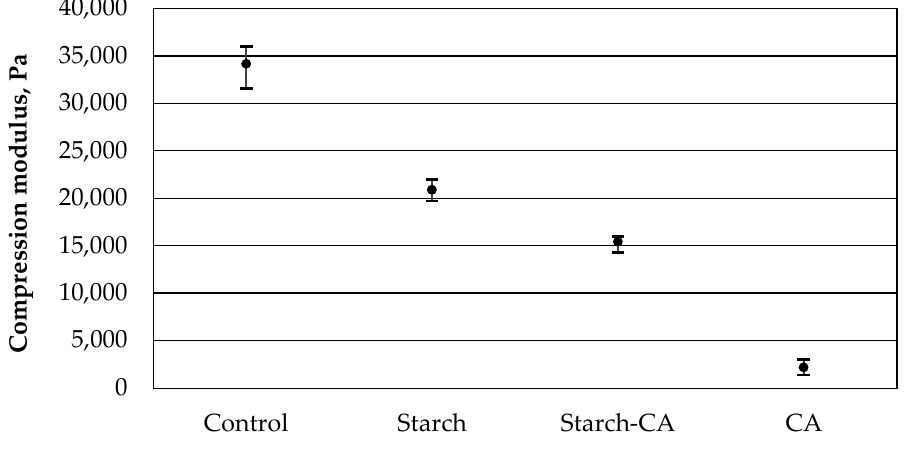
Figure 5. Compression modulus of the different aerogel